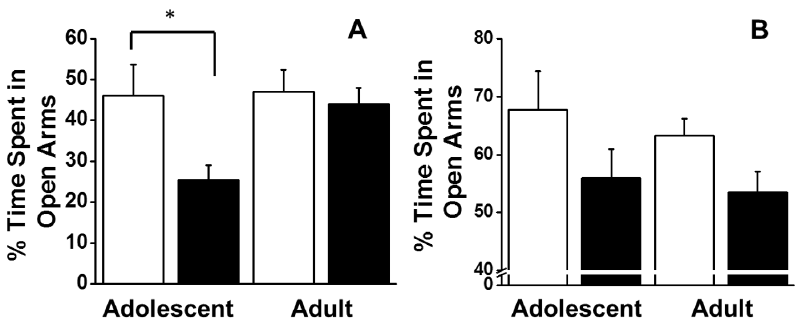
Figure 3. Effects of chronic intermittent ethanol (black bars) or saline (white bars) exposure during adolescence or adulthood after the 15 m delay, (during training, panel A) and after the 3 h delay (panel B) on%time spent in the open arms. Data is expressed as group mean 6 SEM (n=5 adolescent saline, n=5 adolescent CIE, n=5 young adult saline, n=7 young-adult CIE, n=6 adult saline, n=6 adult CIE). Asterisk denotes a significant difference between the animals pre-treated in adolescence with ethanol vs. saline ( Post-hoc t-test, p , 0.05).